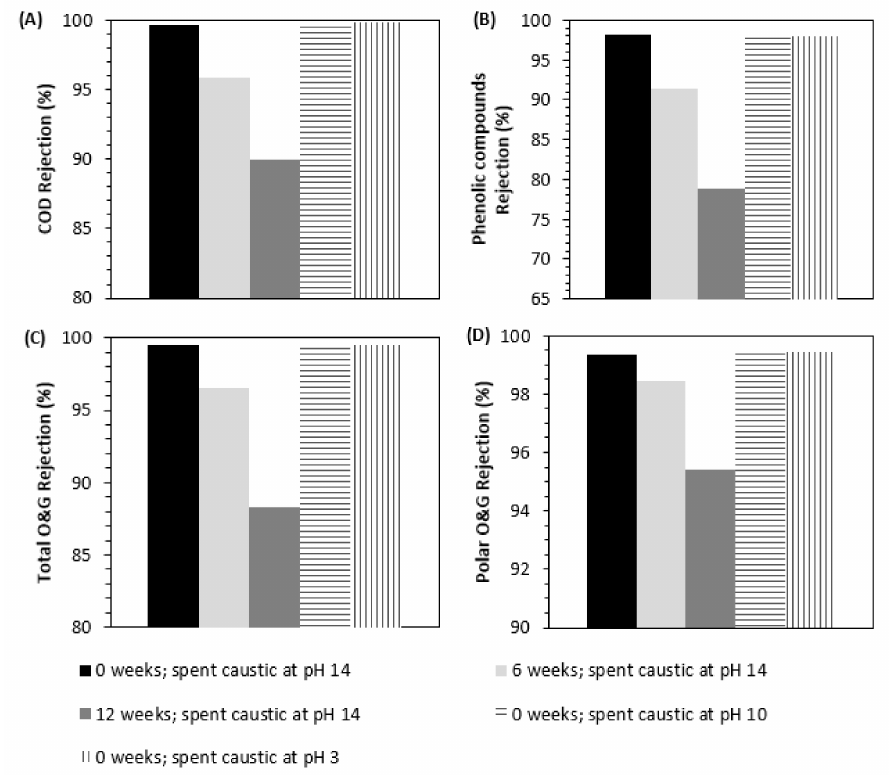
Figure 2. Apparent rejection of contaminants during membrane separation with aged membranes for 0 (pristine membrane), 6 and 12 weeks with spent caustic at pH 14 and pristine membranes with spent caustic at pH 10 and 3. ( A ) COD, ( B ) phenolic compounds, ( C ) total O&G, ( D ) polar